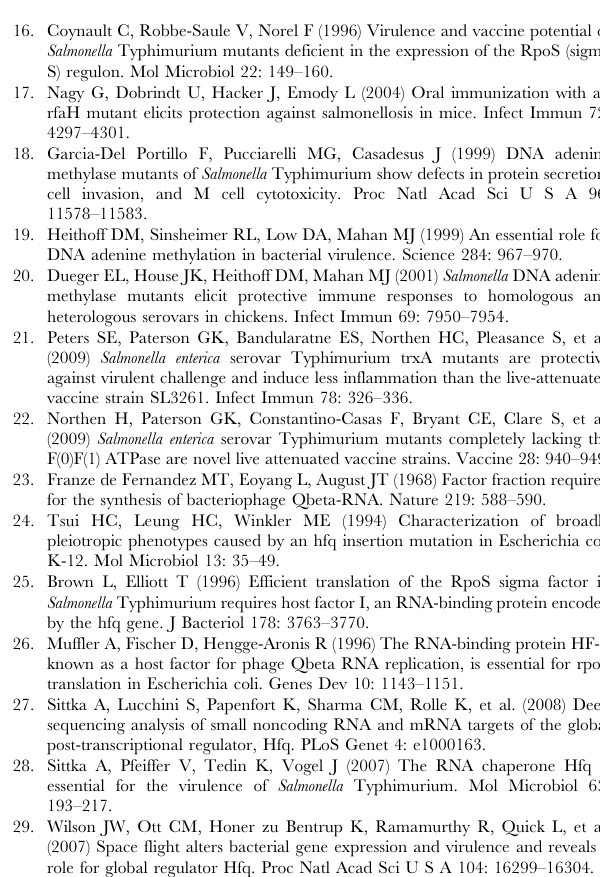
post vaccination. For CFU analysis mice were challenged with 10 7 and for survival assay 10 8 CFU of WT. (TIF) Figure S3 Flow cytometric analysis of CD8 + T cell population in the spleen on 4 th day and 7 th day of post infection. Groups of mice were inoculated with the STM-WT or STM D hfq with dose of 10 7 bacteria per mouse. Uninfected mice were used as control. Splenocytes were isolated on 4 th and 7 th day of post infection from both infected and control mice and stained with PE- conjugated anti-CD8 MAb. The relative levels of CD8 + T- lymphocytes were measured through FACS. Data was analyzed with BD Cell-Quest software and represented by dot plots. The results are representative of two independent experiments. Each group consisted of 4-5 mice. (TIF) Figure S4 Flow cytometric analysis of splenic CD8 + T cell population in vaccinated and unvaccinated mice with or without challenge. Group of mice were orally given PBS or 10 8 STM D hfq and then challenged after seven days of post vaccination with 10 7 CFU of STM-WT per mouse. On 7 th day post vaccination (from unchallenged mice) and 7 th day post challenge (from challenged mice) spleen were isolated and single cell suspension of splenocytes were prepared followed by staining with FITC- conjugated anti-CD8 MAb. The relative levels of CD8 + T- lymphocytes were measured through FACS. Data was analysed by